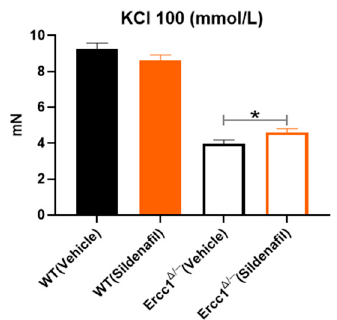
Figure 6. Maximum contraction response of aortic rings from Ercc1 Δ / − mice versus their WT littermates to 100 mmol/L KCl. Statistical differences were analyzed by two-tailed t-test (*, p < 0.05).